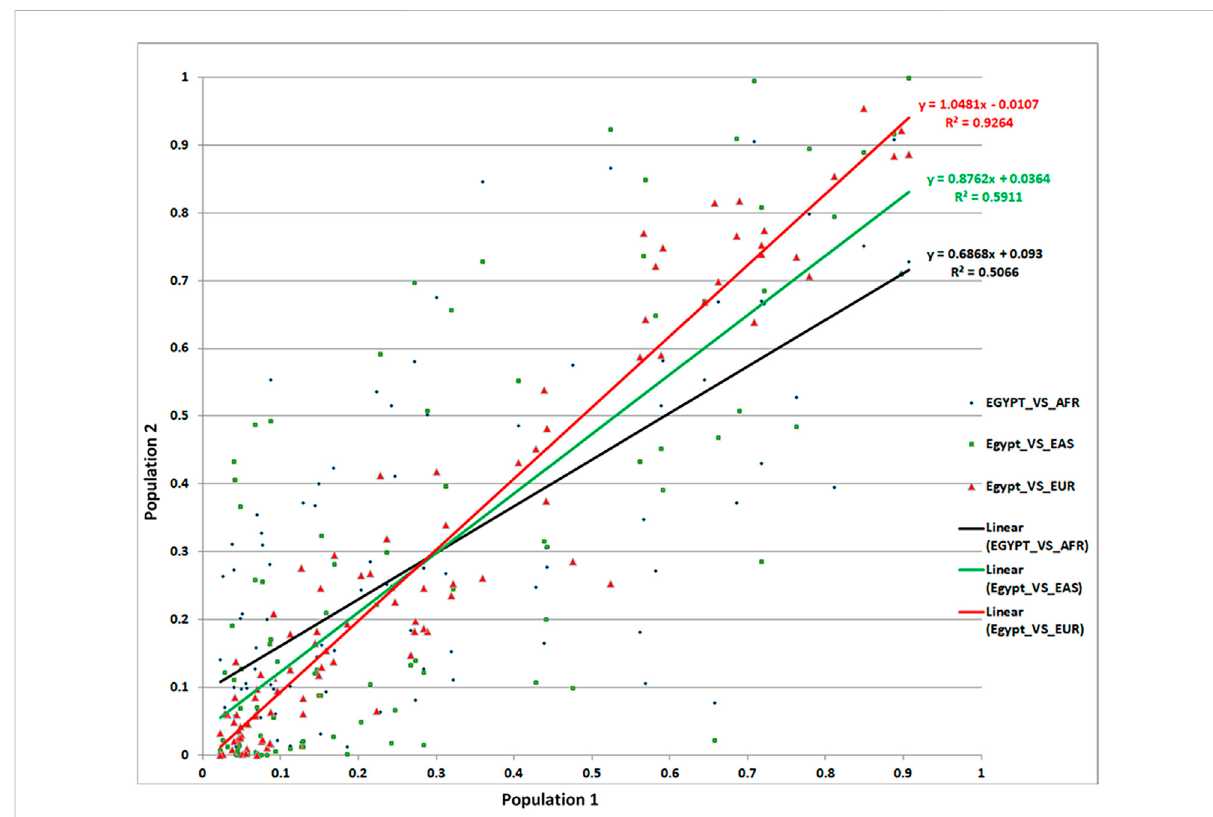
FIGURE 4 Comparison of MAFs for the associated SNPs from our Egyptian controls and 1,000 Genomes